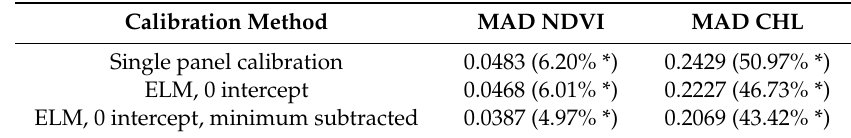
Table 5. MAD of Sequoia derived vegetation index (VI) values (NDVI and CHL) for the three calibration approaches, estimated from the comparison with HyPlant derived index values.